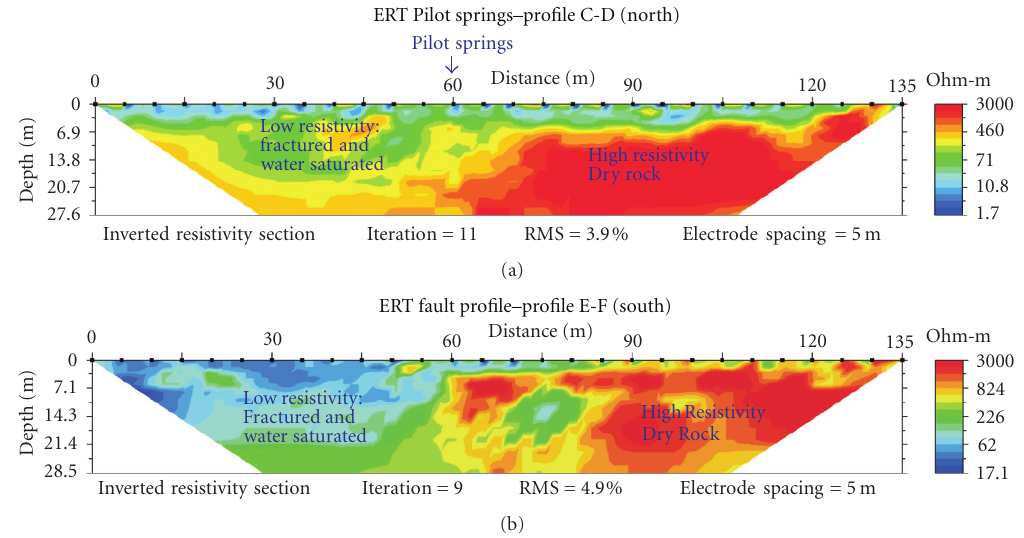
Figure 9: (a) ER tomography resistivity section close to Pilot Springs using Wenner and dipole-dipole arrays. (b) ER tomography resistivity section across mapped fault using Wenner and dipole-dipole